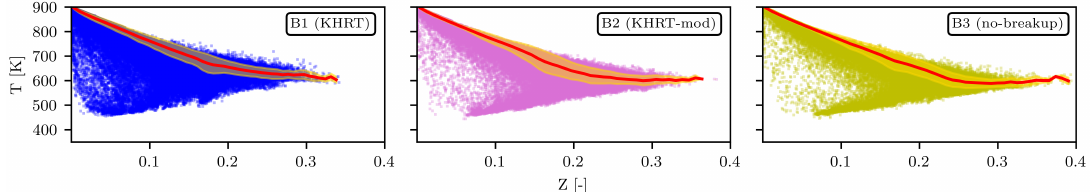
Figure 10. Scattered data points of temperature fields in Z space for spray region ( Z > 10 − 4 ), overlayed with conditional means (red curves) and standard deviations (filled regions) for cases B1–B3 in Table